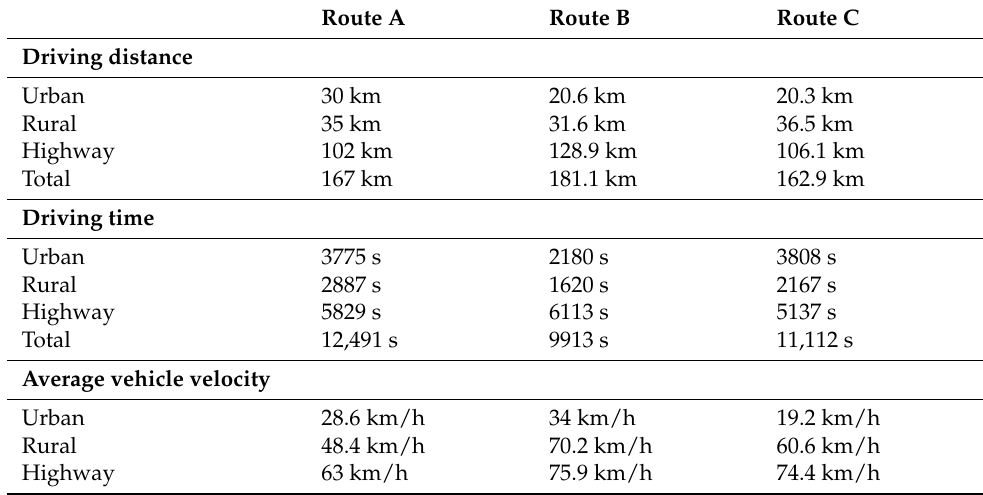
Table 3. Driving characteristics of each